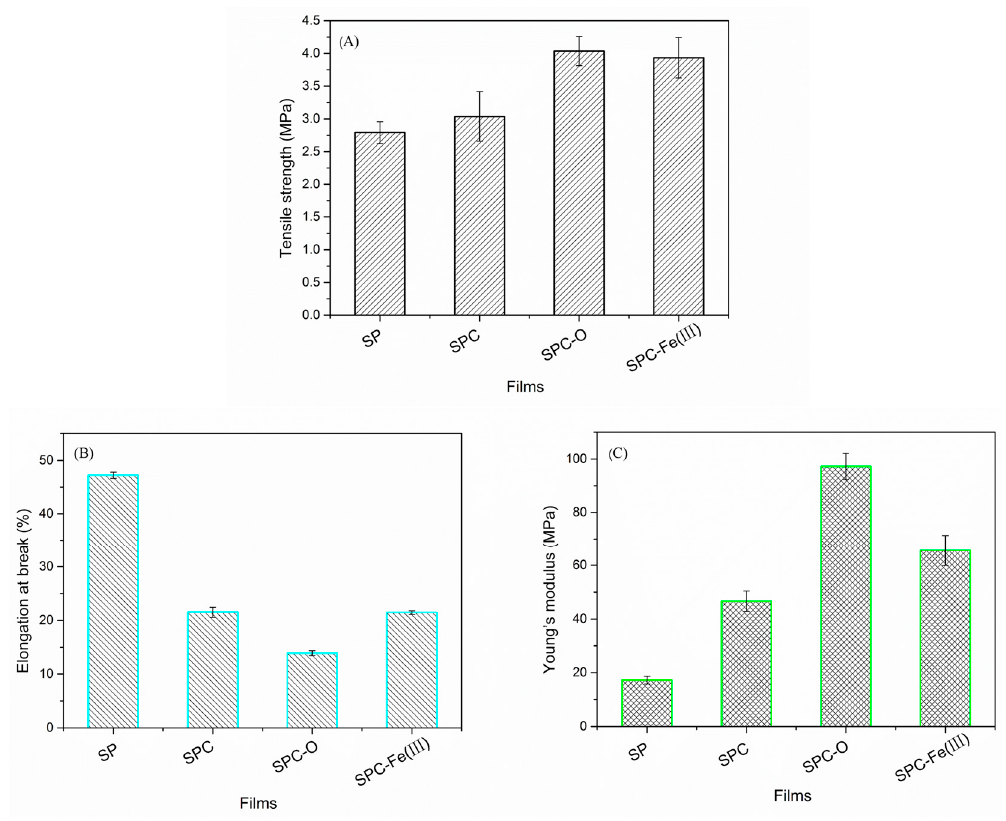
Figure 5. Tensile properties ( A ) TS; ( B ) EB; and ( C ) YM of control and soy-based composite films.